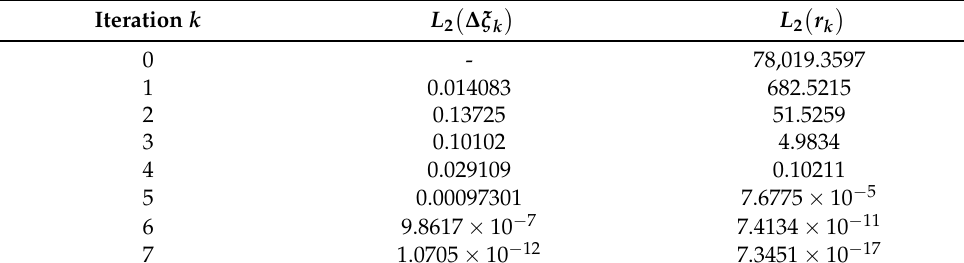
Table 1. First eight iterations for the hyperbolic paraboloid.